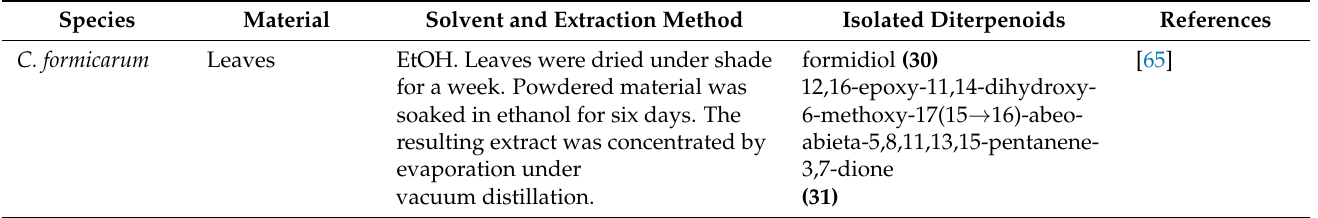
Table 4. The diterpenoid extraction method and C. formicarum plant material for diterpenoid